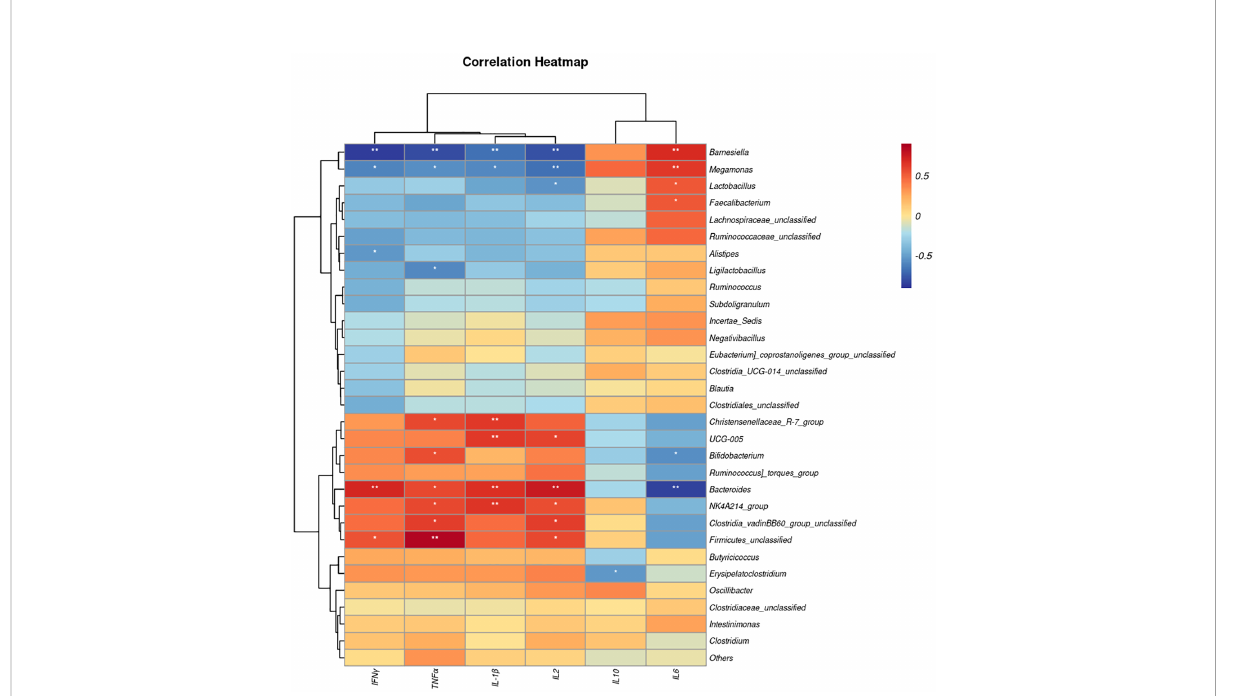
FIGURE 8 The heat map represents the correlation between serum cytokine levels and caecal microbiota taxa in the EP+YG vs control broiler chickens. * P < 0.05 and ** P <0.01. IL-1 b , Interleukin 1 beta; IL-2, Interleukin 2; IL-6, Interleukin 6; IL-10, Interleukin 10; TNF- a , Tumor necrosis factor- alpha; IFN